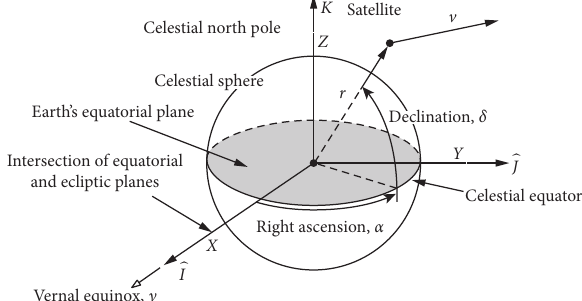
Figure 1: Geocentric coordinates of the